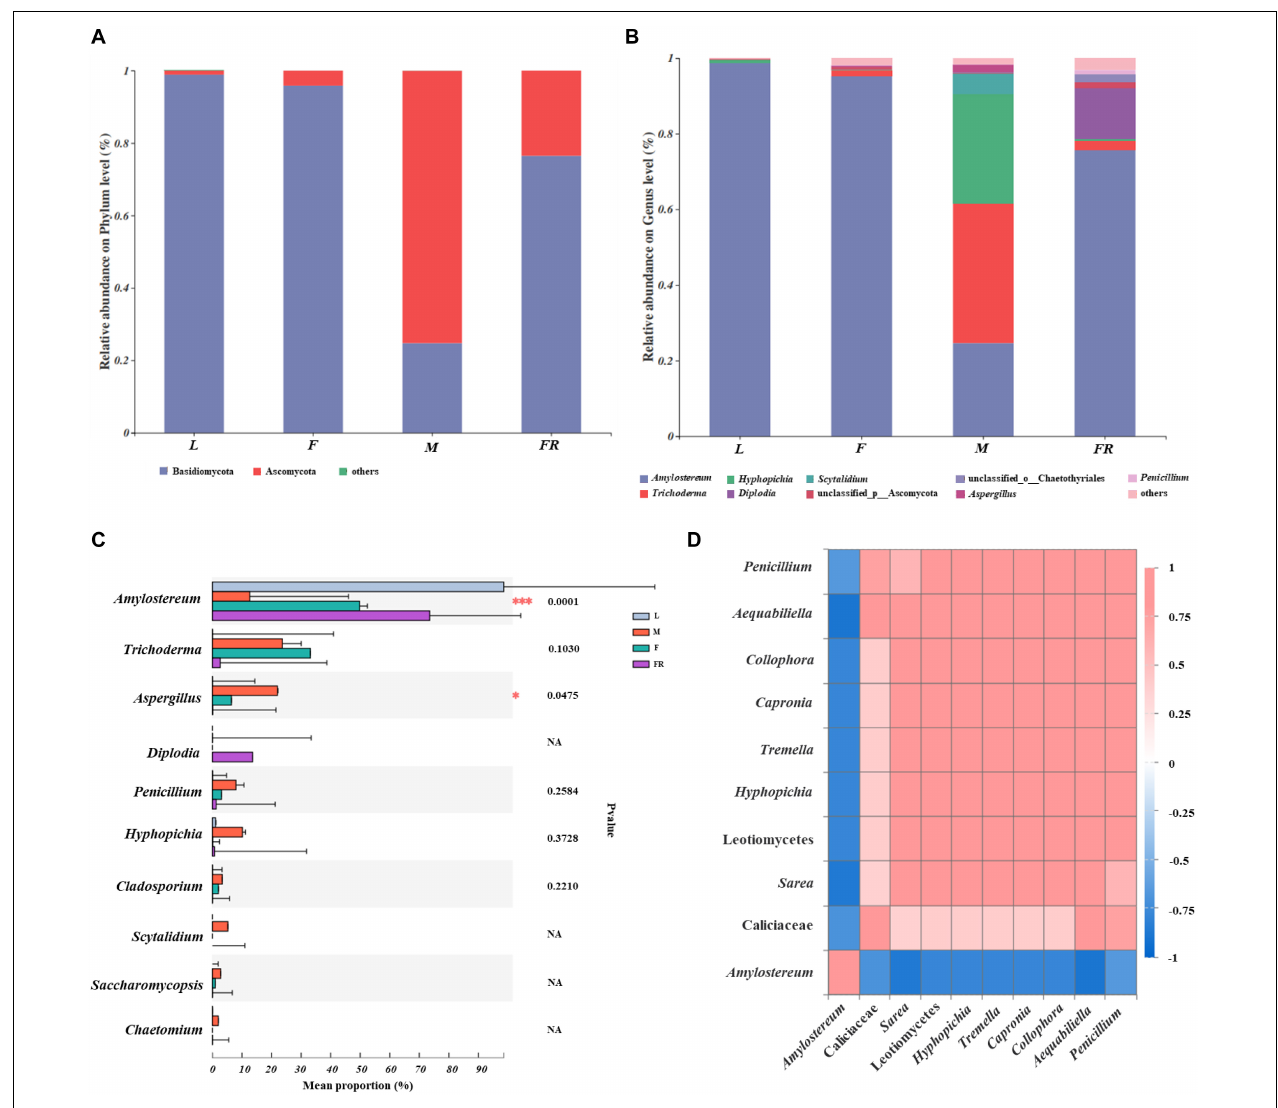
FIGURE 5 | Taxonomic composition of fungal communities associated with Sirex noctilio gut and frass. Relative abundance of each fungal phylum and genus (A,B) . Each bar is indicated by a different color at phylum and genus level. OTUs that were < 1% of average relative abundance in groups are summarized as “others”. (C) Significant differences of microbial composition in larvae, female adults, male adults and frass in the relative abundance of top ten (one-way ANOVA followed by Scheffe test, ∗ 0.01 < P ≤ 0.05, ∗∗∗ P ≤ 0.001). (D) Spearman correlations of samples with the OTU abundance of genus in S. noctilio larval gut in the relative abundance of top ten. Bule boxes represent co-exclusion/negative correlations; red boxes represent co-occurrence/positive correlations between microbes (L, larva; F, female; M, male; and FR,